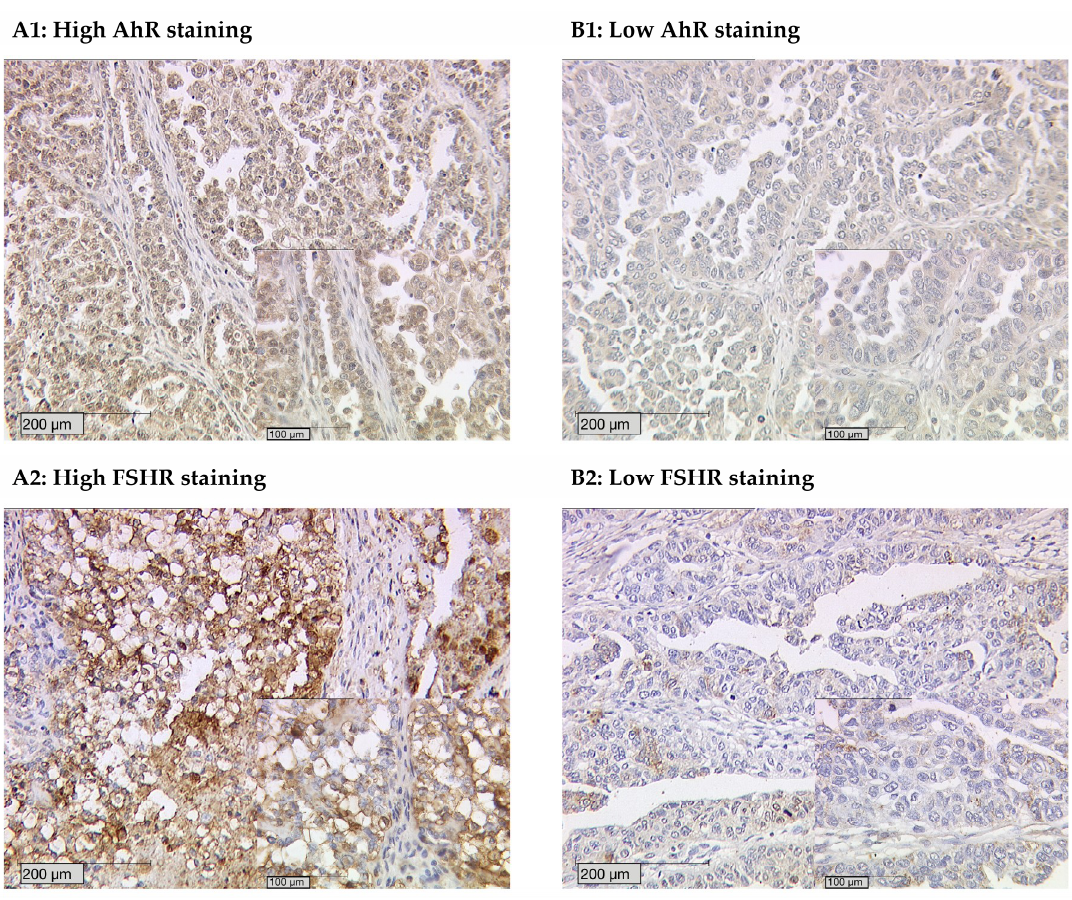
Figure 2. AhR staining intensity correlates with FSH receptor expression. High AhR staining ( A1 ) corresponds with high follicle-stimulating hormone receptor (FSHR) staining ( A2 ). Low AhR staining ( B1 ) correlates to low FSHR ( B2 ) found in specimens from the same patients.